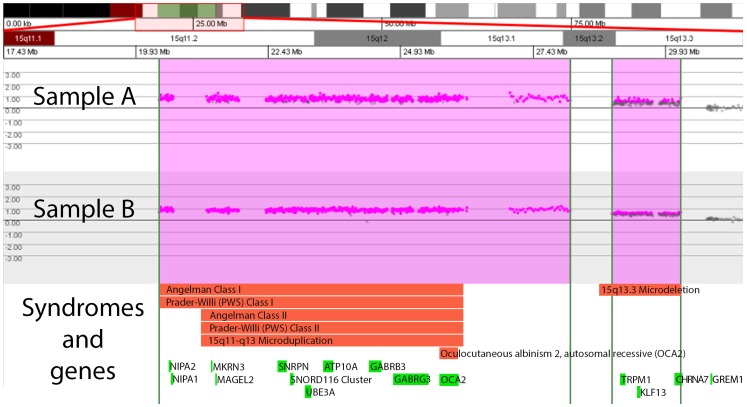
Identical complex chromosomal rearrangements in chromosome 15 found in 2 prenatal samples with different karyotypes and phenotypes.Sample A karyotype is 46,XY,15q+ dn (Table 3, Case no. 8); Sample B karyotype is 47,XX,+mar from characterization study. Each dot on the X-axis represents one oligonucleotide probe on the respective chromosome position. Two-copy gain is detected at 15q11.2q13.2 with minimum gain of 7.77 Mb. Single copy gain is detected at 15q13.2q13.3 with minimum gain of 1.3 Mb. No probe is located in the segment between the 2 regions of copy gains, therefore the exact number of copy gained is unknown in the segment. The genetic syndromes (red boxes) and genes (green boxes) in the region denoted by Signature Genomics Genoglyphix software are shown in the lower panel.